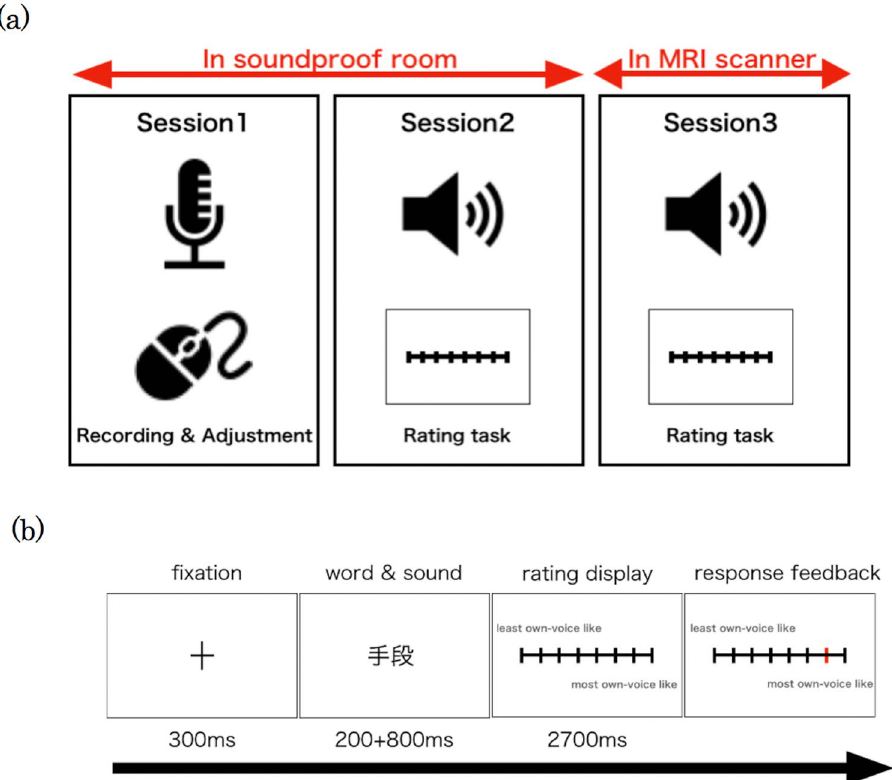
Figure 1. Experimental methods. ( a ) Three sessions were conducted in the experiment. In Session 1, each subject’s voice was recorded and adjusted to reproduce the own-voice. In Session 2, the subjects rated the voice stimuli on an eight-point scale in the soundproof room. In Session 3, the subjects again rated the voice stimuli while the MRI images were acquired. ( b ) Schematic of the task. The subjects rated how much the sound stimuli were like their own voice by pressing the corresponding one of eight buttons. The response was visually shown by changing the